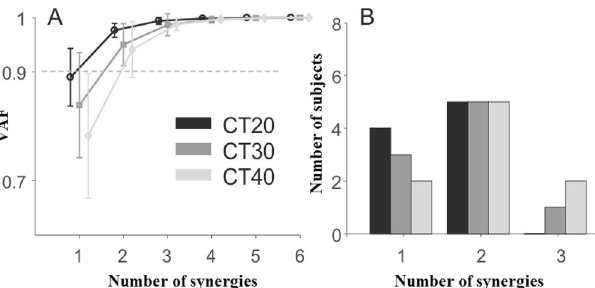
Figure 7. Cumulative variance and number of synergies for the paired participants in each experimental condition. Mean (± SD) of the Variance Accounted For (VAF) as a function of the number of synergies extracted from the joint moments of the loaded arms of the two participants in each pair at the same time ( A ). Frequency histogram illustrates the number of synergies in each condition, as determined by the criterion “VAF > 90%” ( B